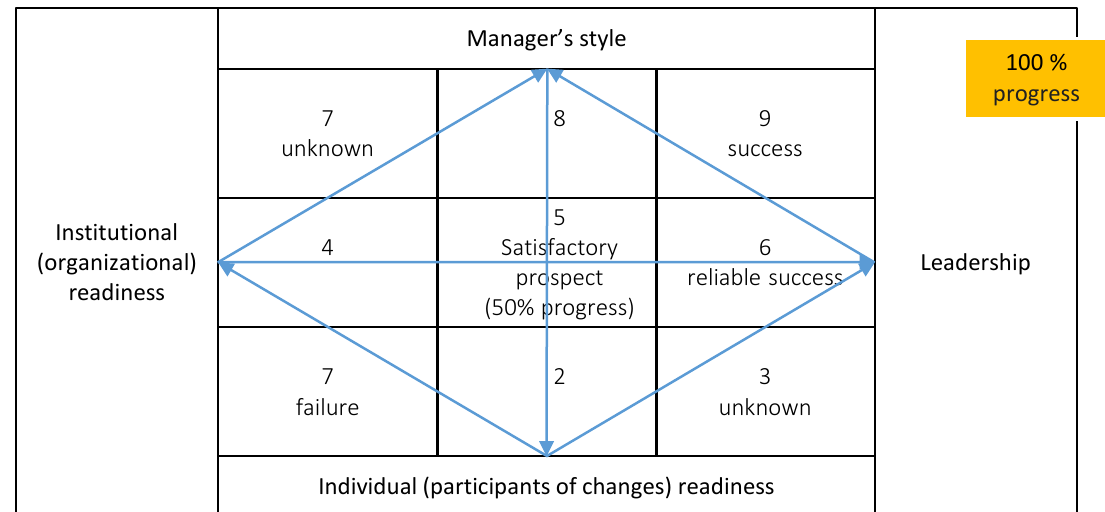
Figure 1. Readiness of educational system of Ukraine for introduction of